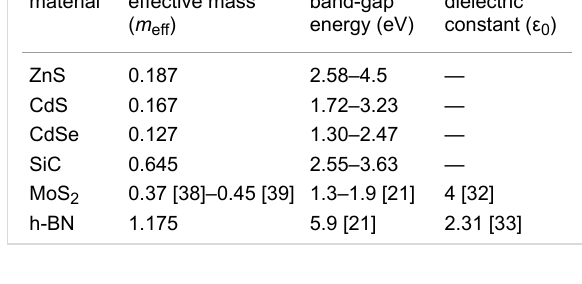
Table 1: Effective masses and band-gap energies of selected 2D ma- terials. ZnS, CdS, CdSe and SiC have a direct band gap at the Γ point. h-BN and MoS 2 have one at the K point. In the literature, values for the dielectric constants (mostly calculated) can only be found for a few ma- terials and, as discussed in the text, they depend on external condi- tions. Therefore, we consider the dielectric constant as a parameter. Unless otherwise stated, the data are taken from